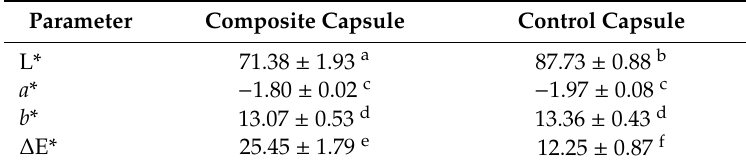
Table 1. Experimental CIELab color parameters (L*, a * and b *), total color di ff erence ( ∆ E*) for composite and control